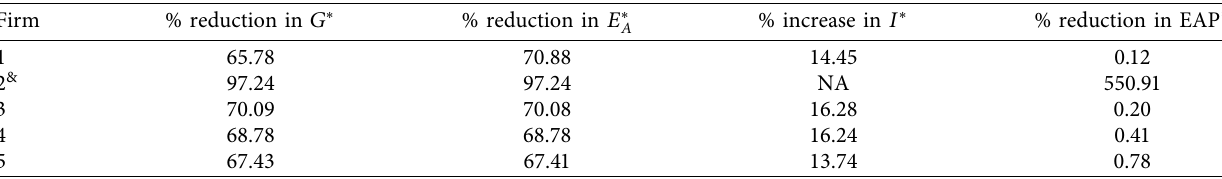
Table 7: Percentage changes in the decision variables in the second year with respect to the first year. Firm